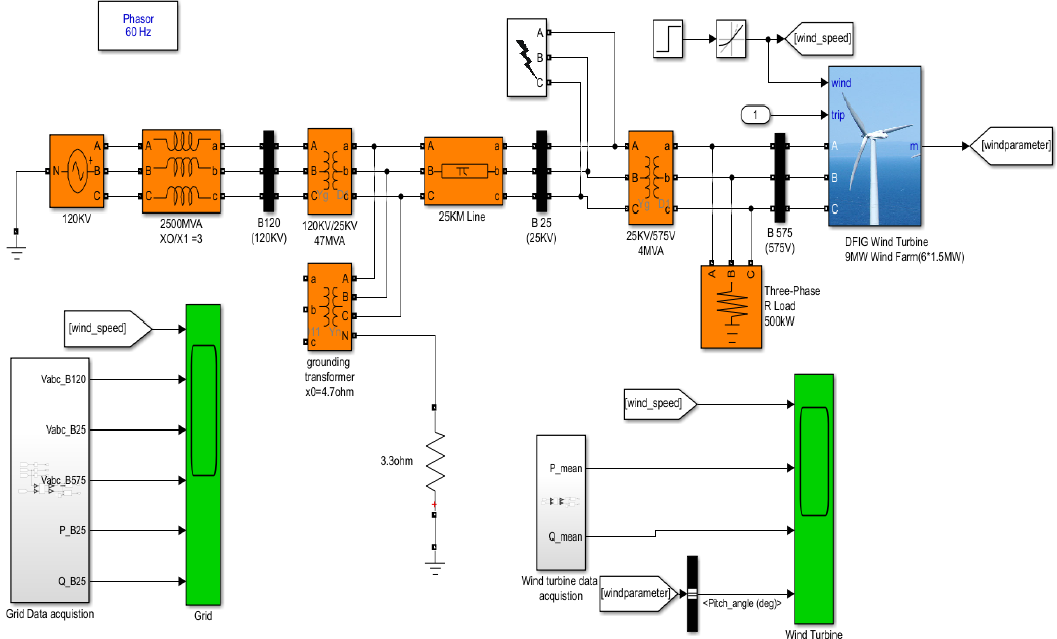
Figure 6. Simulink model of DFIG wind turbine connected to a grid network.